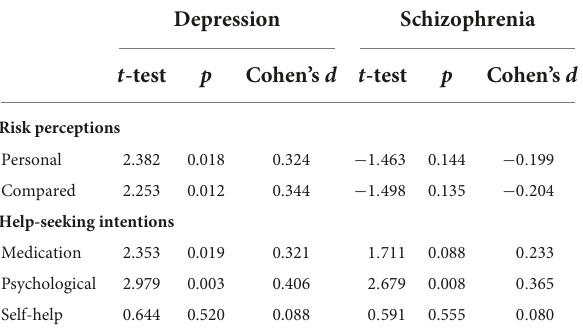
TABLE 3 Gender differences in risk perception and intention to seek help ( df =